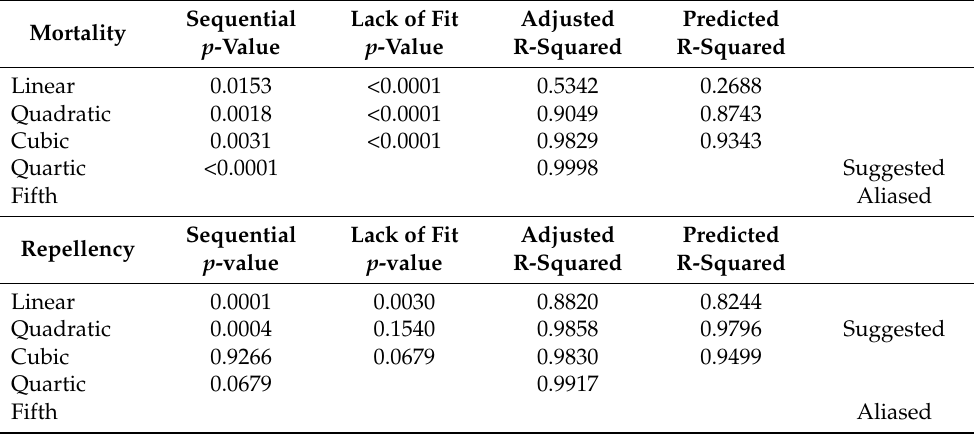
Table 2. Summary of the polynomial models analysed by Design Expert software in the optimization of the O. quixos EO